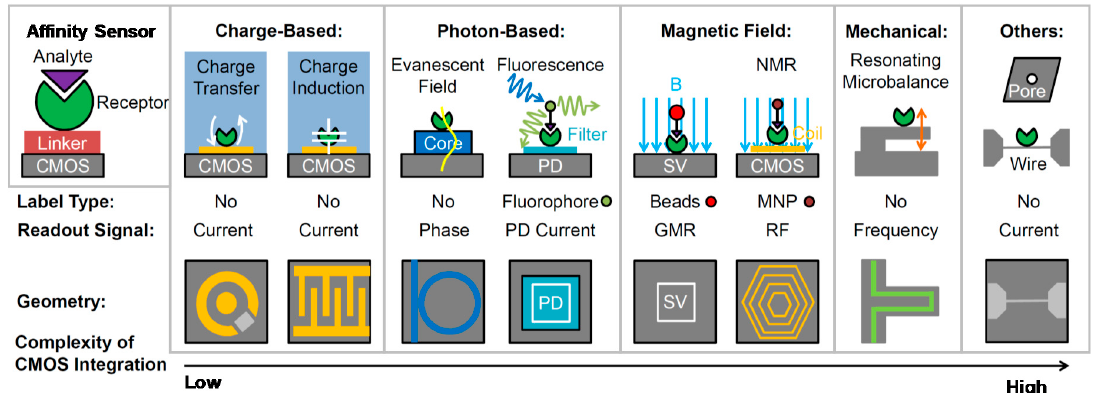
Figure 3. Overview of transducers (based on molecular affinity) on-chip for bio-sensing: electrical, optical, magnetic, mechanical and nano-scaled. The horizontal axis indicates the technological complexity of monolithic integration on CMOS substrates.